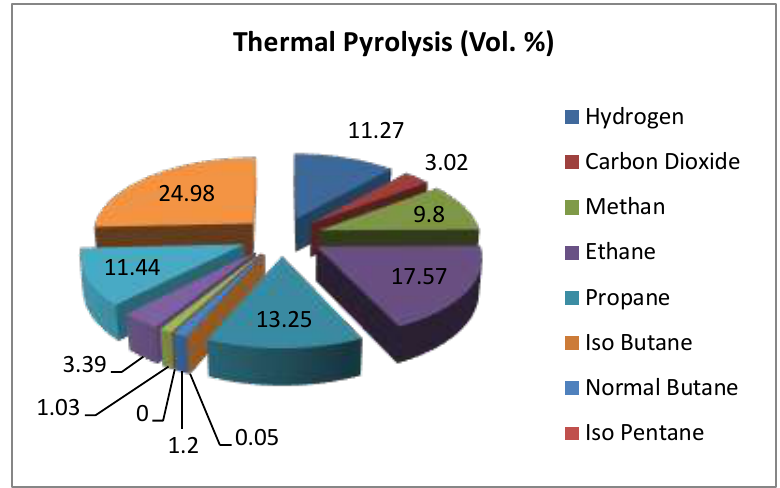
Figure 10: Spectra of hydrocarbons produced in the gas phase from non-catalytic Thermal cracking.